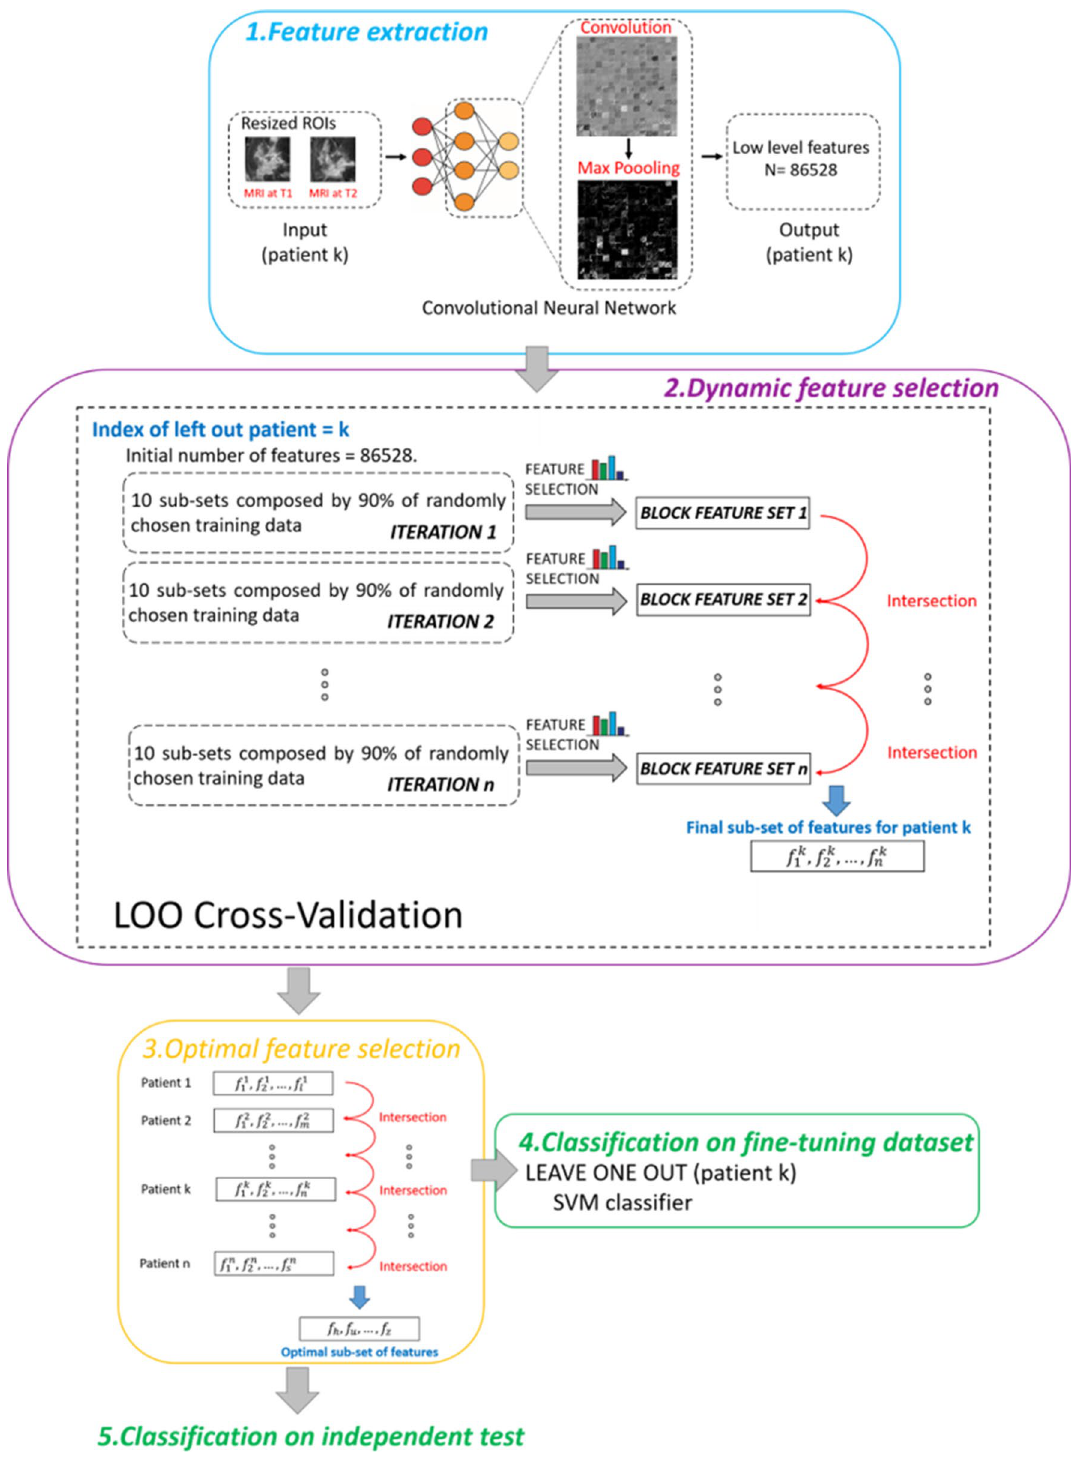
Figure 4. Workflow of the proposed transfer learning method encompassing five steps: 1. Feature extraction, 2. Dynamic feature selection, 3. Optimal feature selection, 4. Classification on the fine-tuning dataset, 5. Classification on the independent